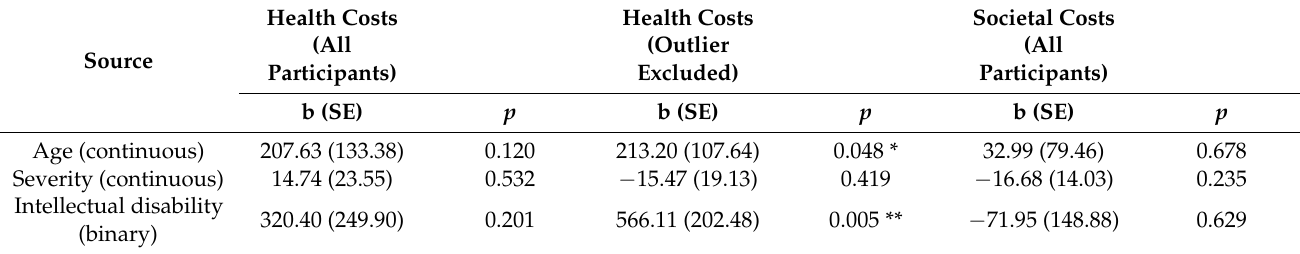
Table 4. Predictors of costs: All